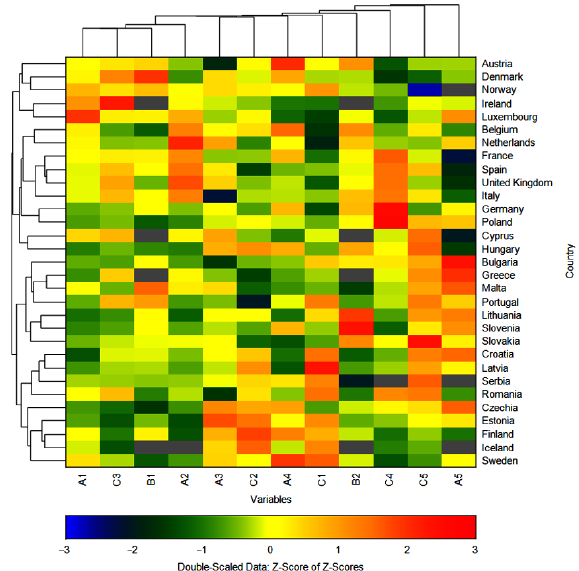
Figure 4. Clustered heat map analysis (source: authors’